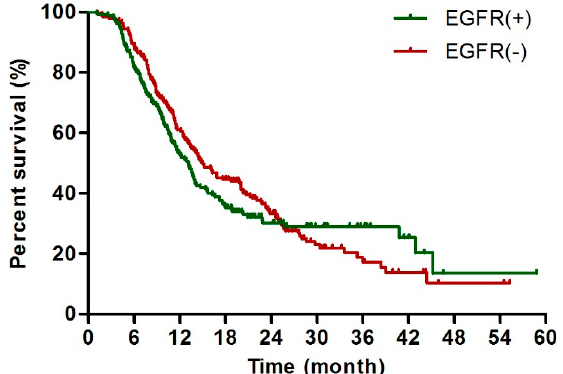
Figure 2. Comparison of overall survival between each EGFR status. Kaplan–Meier Estimates of survival according to EGFR expression (EGFR (+) or EGFR ( − )). The prognosis of patients treated with adjuvant therapy was analyzed in both the EGFR-positive (EGFR (+)) and EGFR-negative (EGFR ( − )) subgroups (Table 3). To further determine the correlation between postoperative chemotherapy (chemo) and EGFR expression, all patients with available final survival data were divided into four Groups: EGFR (+) and chemo; EGFR (+) and no chemo; EGFR ( − ) and chemo; EGFR ( − ) and no chemo. The investigation of OS in these Groups showed a benefit of postoperative chemotherapy in both the EGFR (+) and EGFR ( − ) subgroups. Particularly,